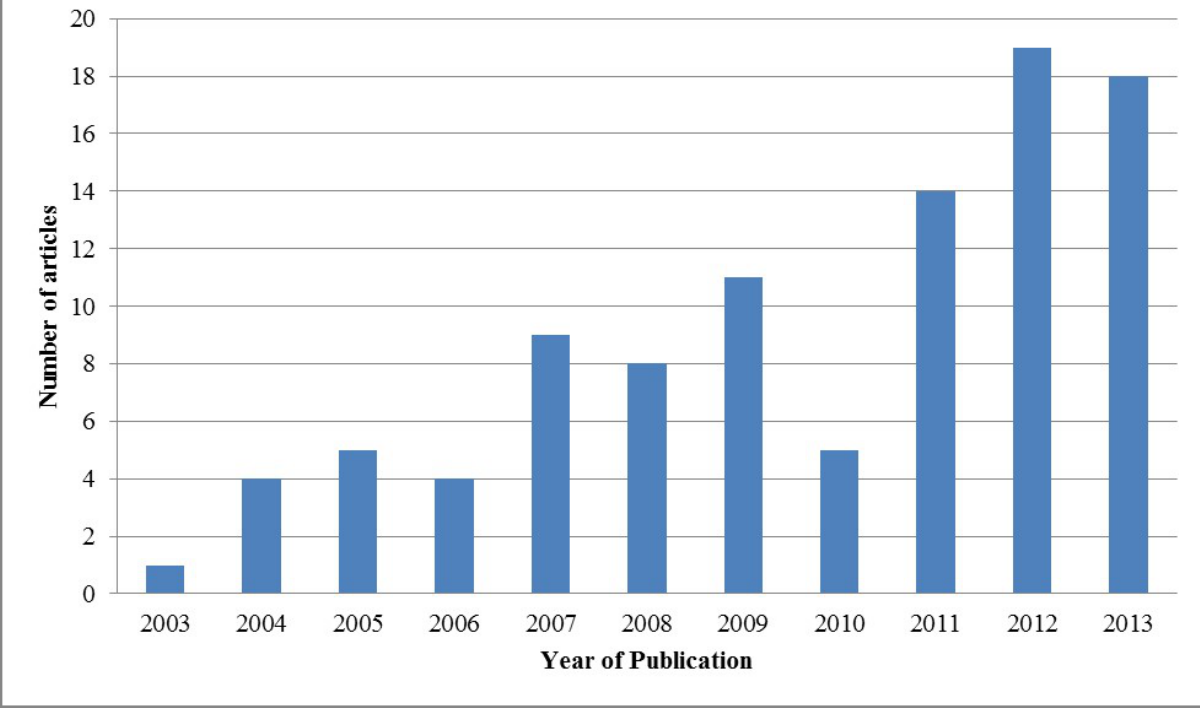
Figure 3. mAdherence studies published by